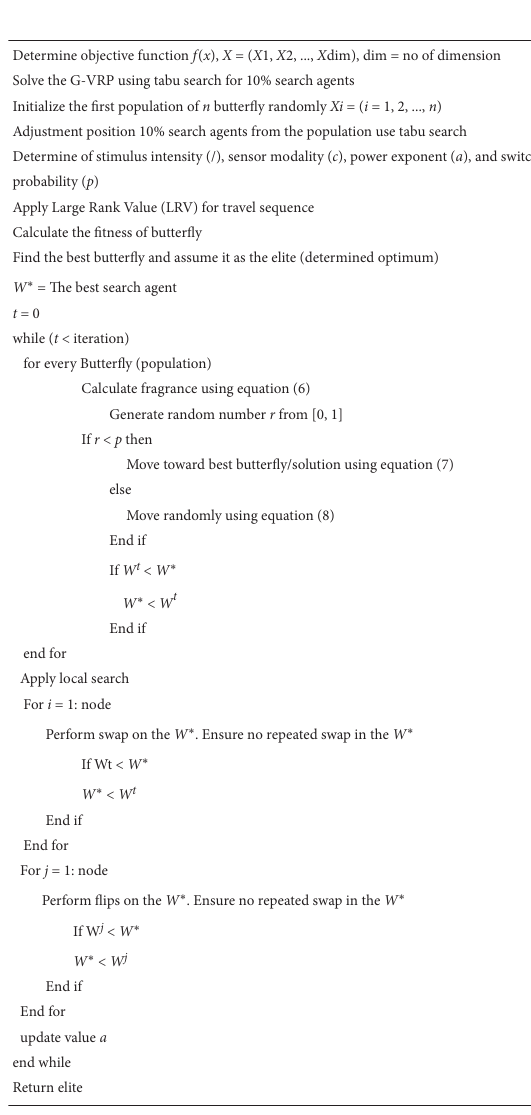
Figure 2: Pseudocode of hybrid butterfly optimization algorithm (HBOA).